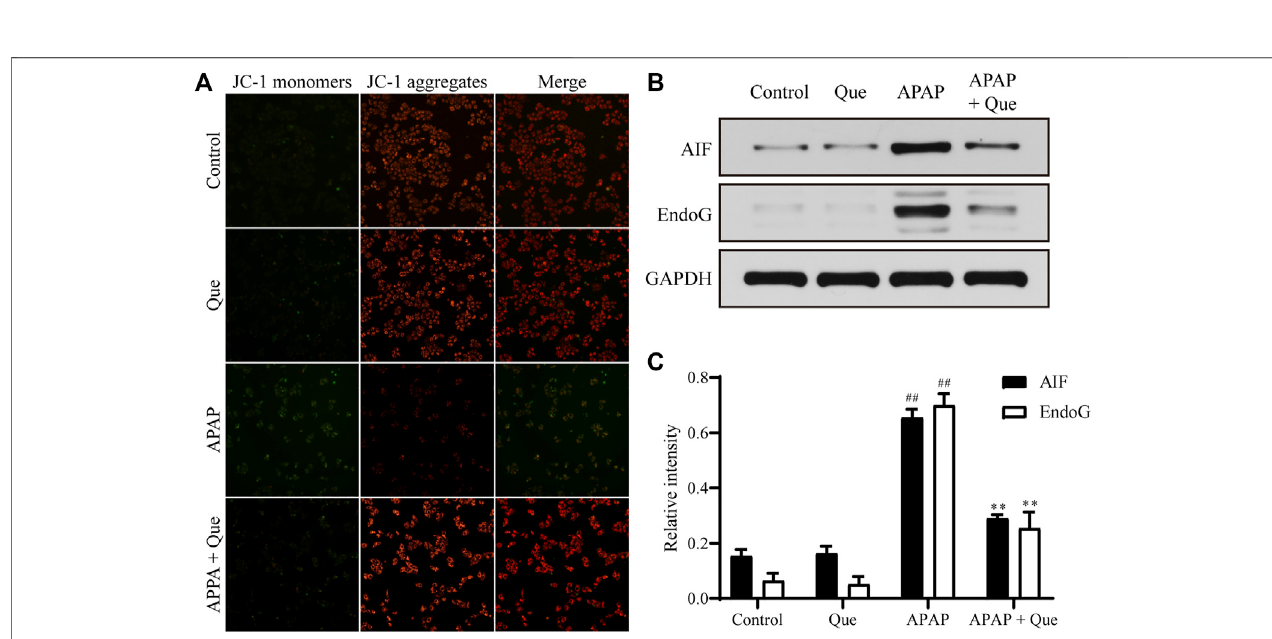
FIGURE 6 | Effect of quercitrin on mitochondria. (A) Effect of quercitrin on mitochondrial membrane potential. (B) Western blot analysis of AIF and EndoG in L-02 cells. (C) Western blotdensitometricanalysis.Theexperimental dataareexpressed asmean ± SD,andtheexperiment wasrepeatedthree times, ## p < 0.01,compared with the control group; ** p < 0.01, compared with the APAP